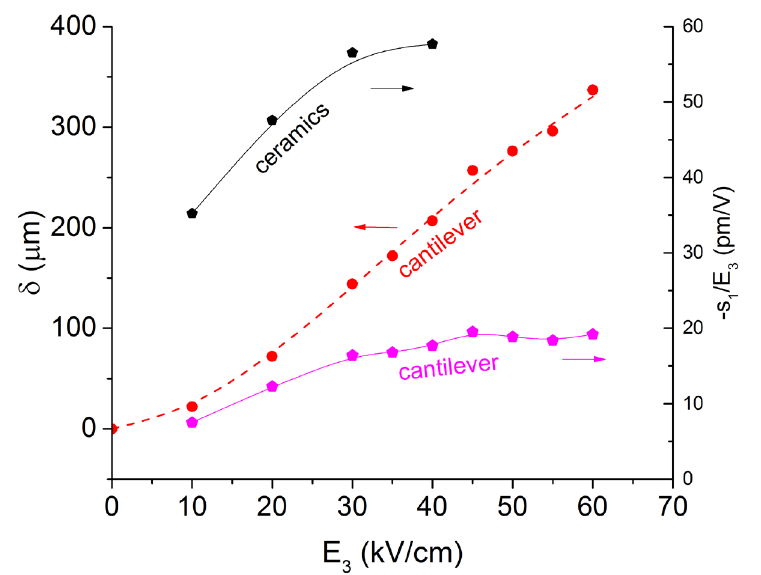
Figure 4. Electromechanical response of PMN ceramics and PMN-based cantilever. Tip displace- ments ( δ ) of the cantilever versus electric field ( E 3 ) are shown as red points with the scale of the displacements given on the left-hand vertical axis. The values were used to calculate the − s 1 / E 3 values (pink symbols), which were then compared with bulk ceramics (black symbols) of the same PMN composition.